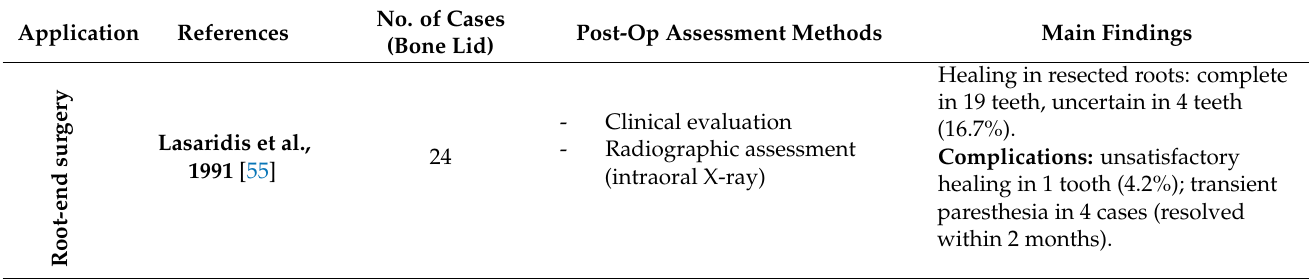
Table 4. Summary of the main results of studies related to different surgical